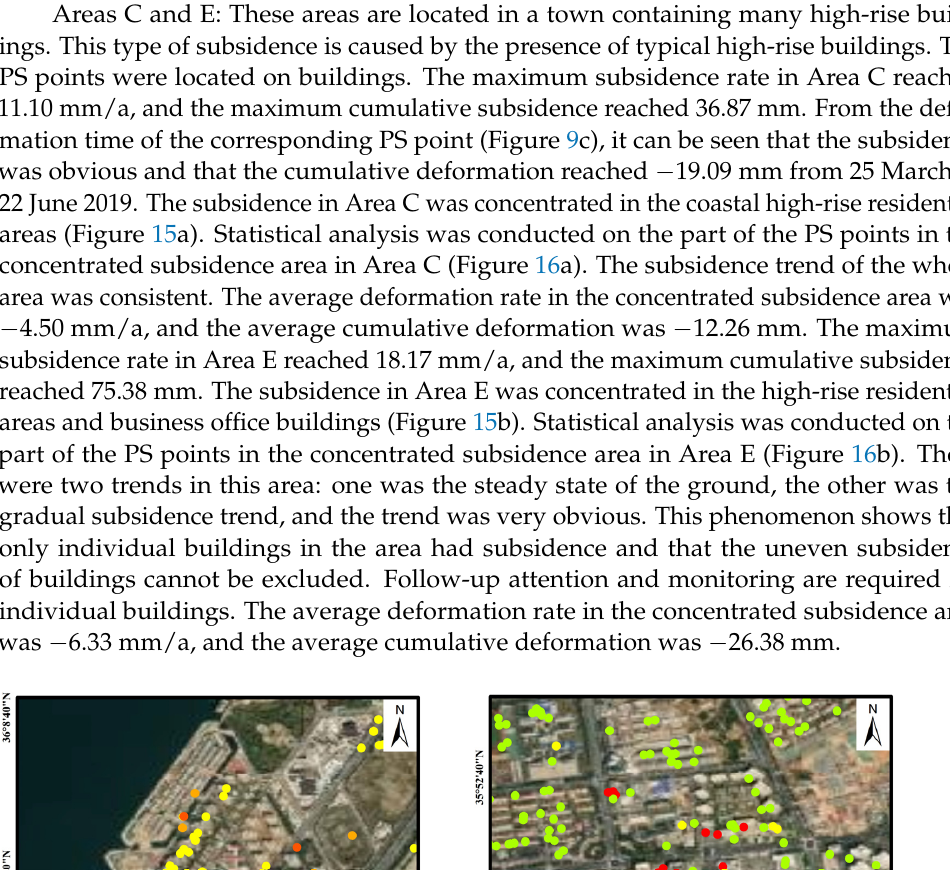
Figure 14. Part of the PS points subsidence of a logistics company in Area B. (Different colors represent different PS points).